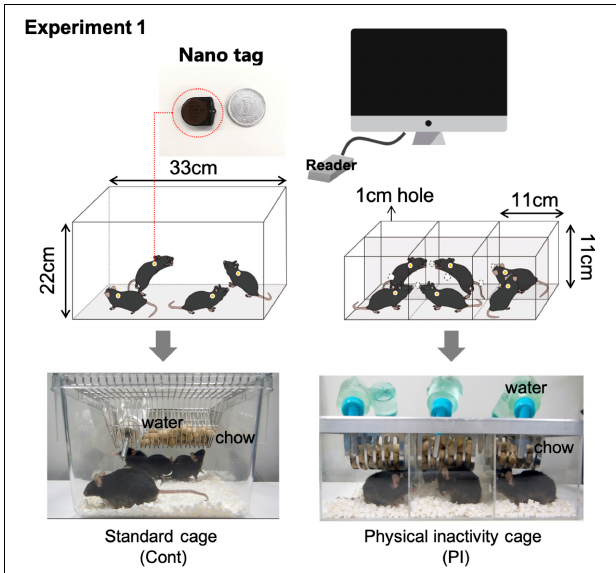
FIGURE 1 | Measurement of the daily physical activity of mice using nano-tag apparatuses. Graphical explanation of measurement of the daily physical activity of mice using the nano-tag